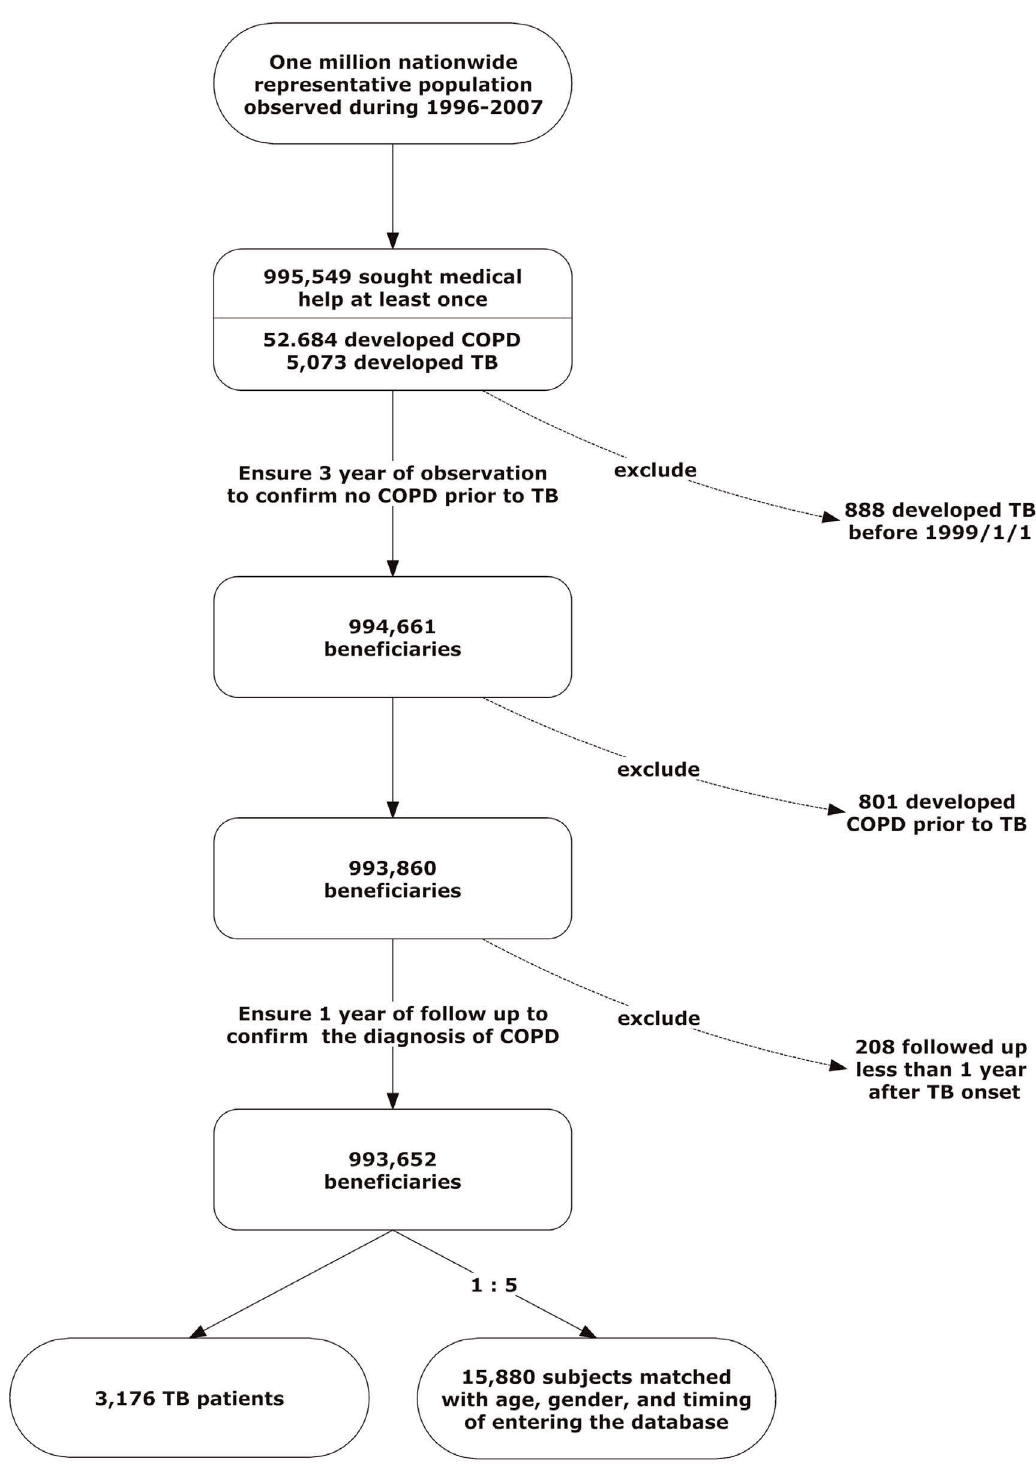
Figure 1. Case selection flow chart. The selection of pulmonary tuberculosis (TB) patients and age- and sex-matched control subjects from the Longitudinal Health Insurance Database 2005.